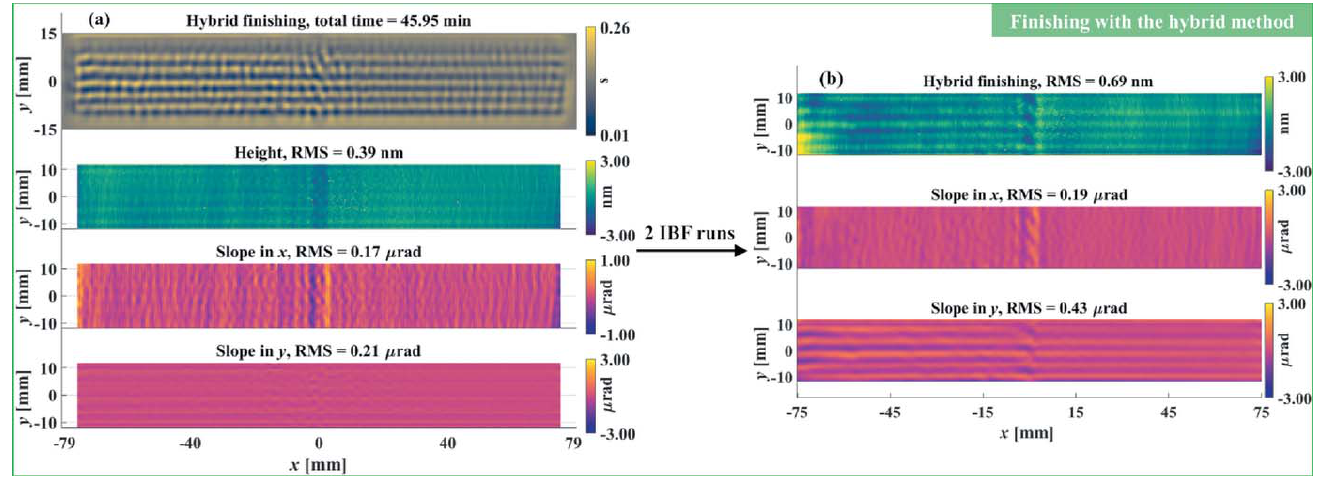
Figure 14 The finishing was guided by the estimation obtained from the hybrid method ( a ). The finishing result after two IBF runs was measured with the SI system ( b